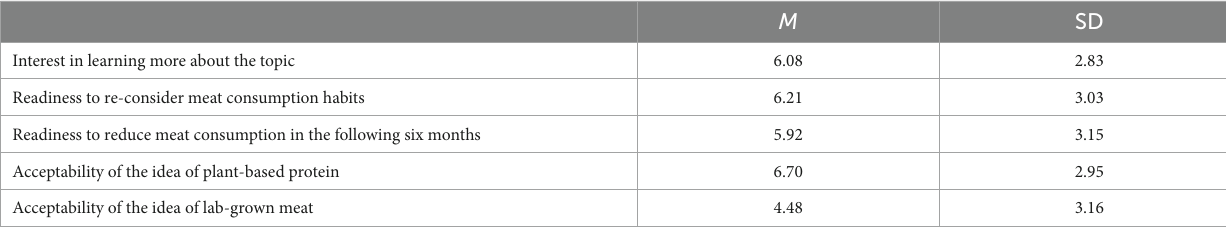
TABLE 2 Openness to meat reduction and alternative protein sources ( N = 271).